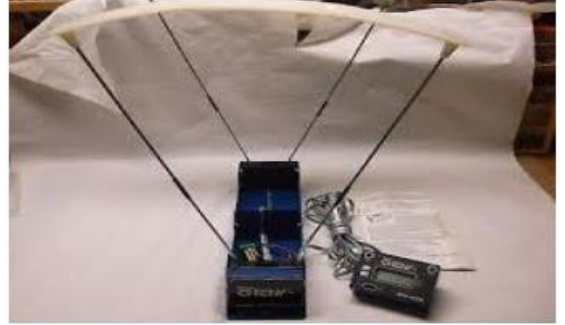
Fig.1: M-1 shooting Chrony.